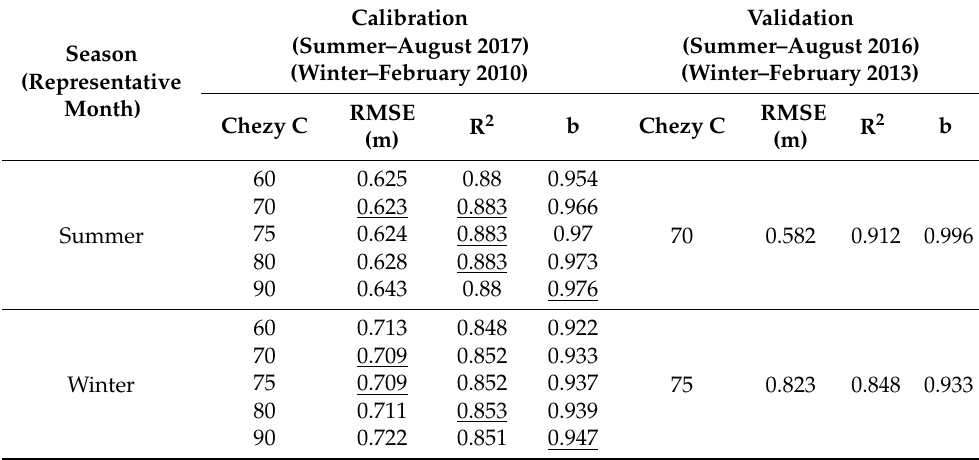
Table 4. Calibration and validation metrics comparing observed and simulated tidal heights for different seasons as a function of Chezy C. Best values for each metric are